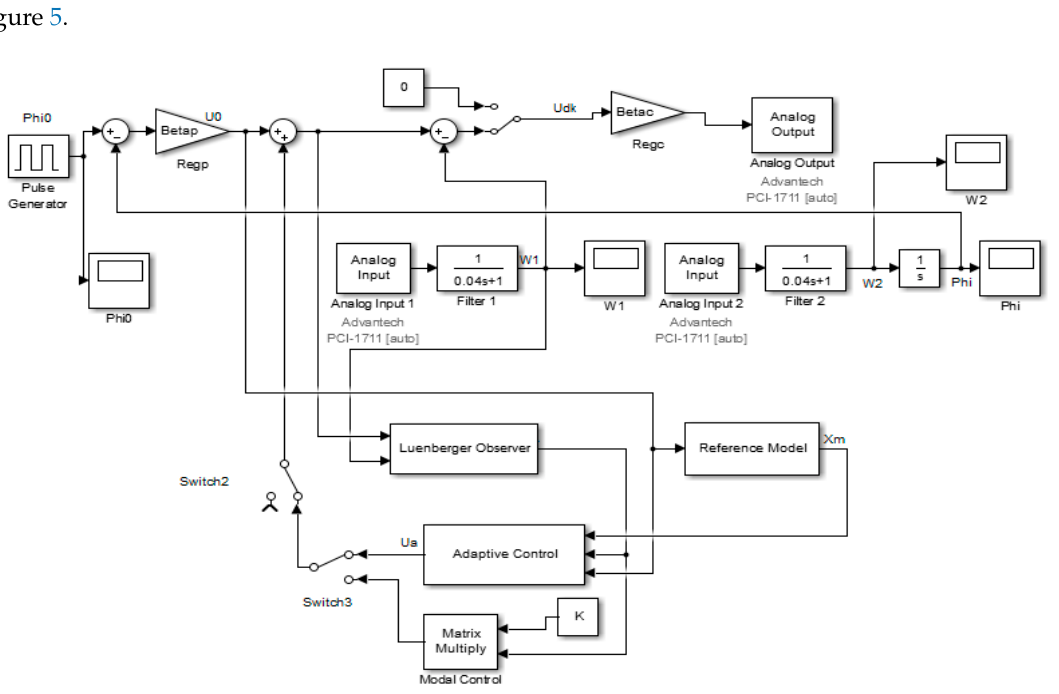
Figure 5. The structure of the real-time controller.